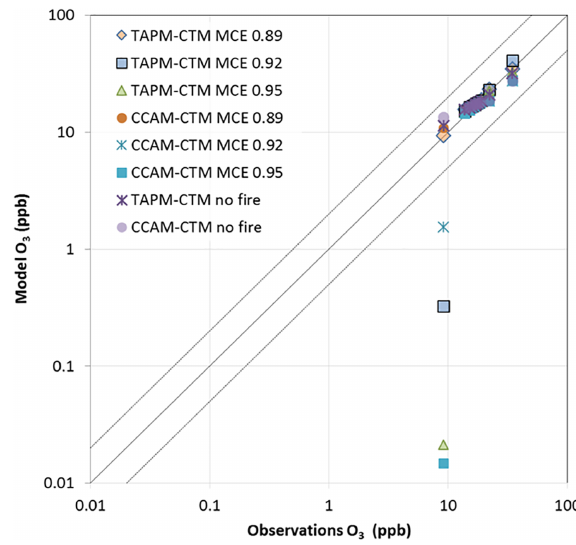
Figure 9. Quantile–quantile plots of observed and modelled O 3 for the TAPM–CTM and CCAM–CTM simulations. For each scenario, the model–data pairs correspond to the following percentiles: 0.2, 0.3, 0.4, 0.5, 0.6, 0.7, 0.8, 0.9 and 1. Note the log scale on both axes. The solid line is 1 : 1 and dotted lines show performance within a factor of